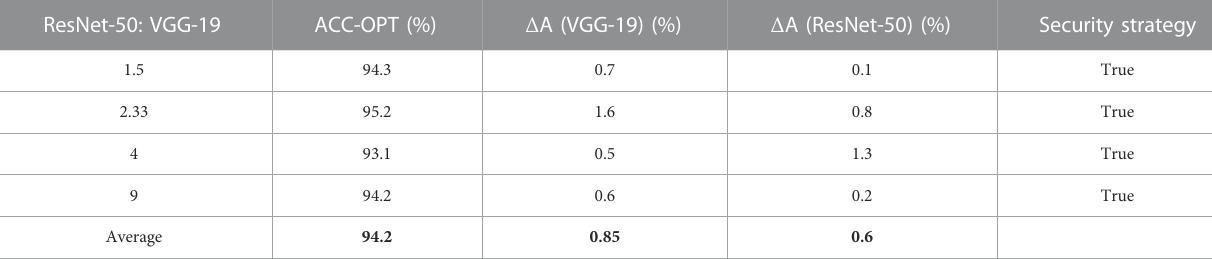
TABLE 4 Experimental results of model-weighted fusion.